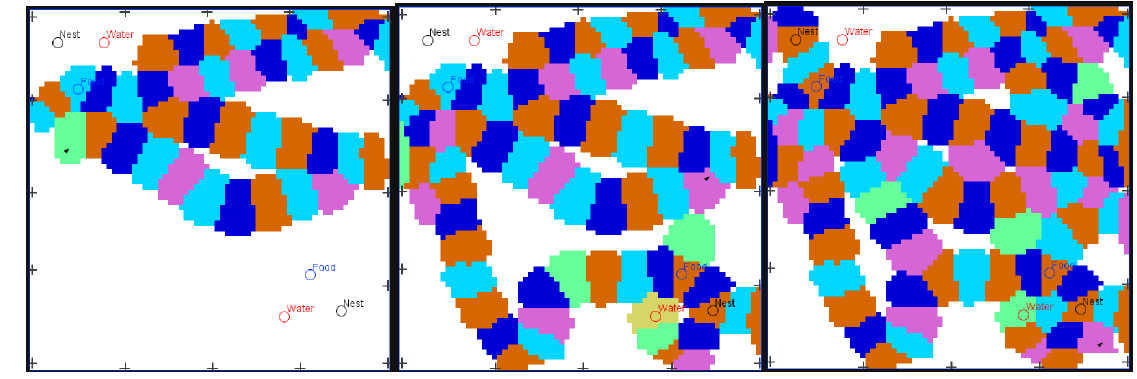
(leftpicture), t (middle)and t = 500 = 1500 = 5000 (right). Each homogeneous region represents a zone with the same winner (its place field). Colors are randomly chosen to avoid two contiguous regions